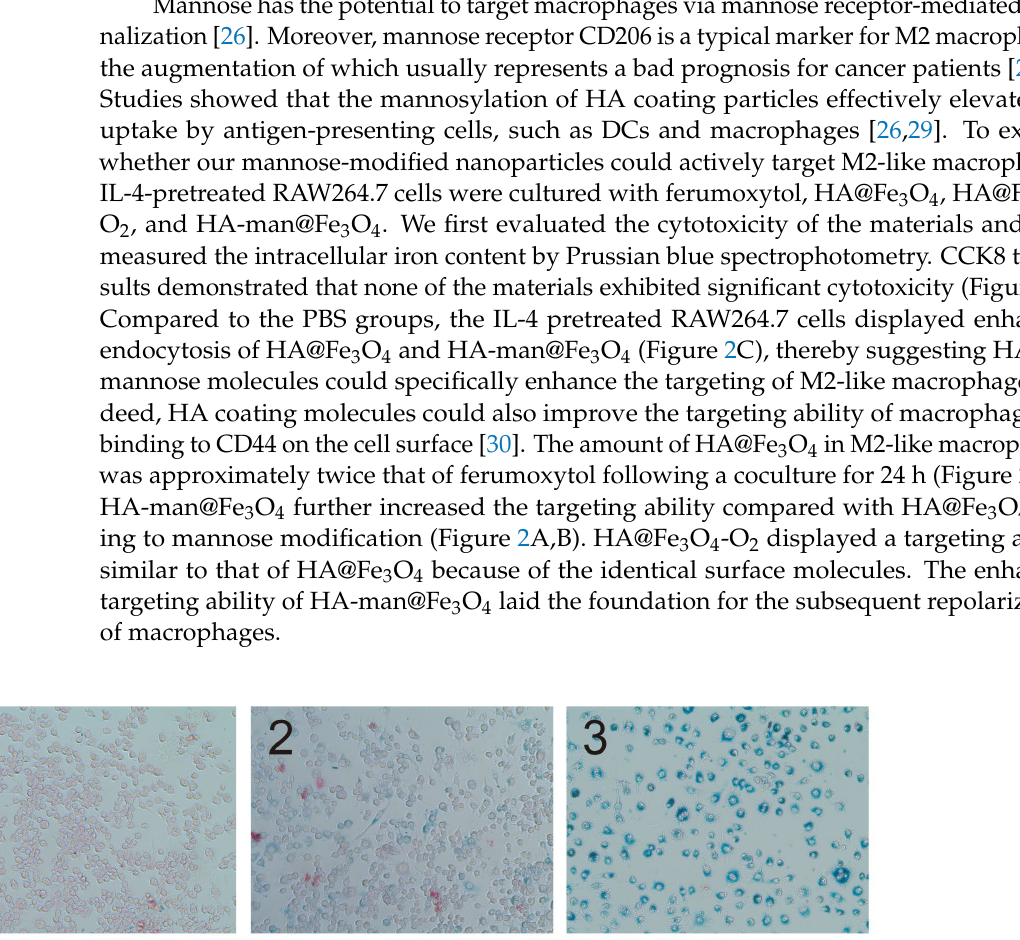
Figure 2. RAW264.7 cells cocultured with different iron oxides in vitro. ( A ) Prussian blue staining images of RAW 264.7 cells; ( B ) Fe amount in RAW 264.7 cells. Cells were incubated with 200 μg mL −1 iron oxides in Fe for 24 h. ( C ) The targeting abilities of iron oxide nanoparticles with different coating molecules towards macrophages. PBS or IL-4 stimulated RAW264.7 cells were cocultured with materials for 24 h before testing. Error bars indicate at least three independent experiments. p - value has been calculated by the one-way ANOVA test. * p < 0.05 and *** p < 0.001. 3.3. Repolarization of M2-like Macrophages In Vitro We sought to determine the effect on M2-like macrophage repolarization based on the enhanced targeting abilities. CD86 and CD206 are typical M1 and M2 markers, respec- tively. Therefore, we treated macrophages with various iron oxide nanoparticles and ex- amined changes of the two markers after coincubation. The HA-man@Fe 3 O 4 -treated CD86 + cells expanded to approximately 90%, whereas the control group displayed only approximately 20% CD86 + cells (Figure 3A,B). Cells treated with commercialized fer- umoxytol also promoted the expression of CD86 to approximately 50%, consistent with former studies. In addition, CD206 expression decreased significantly following treatment with HA-man@Fe 3 O 4 (Figure 3C,D). Interestingly, the expression of CD86 and CD206